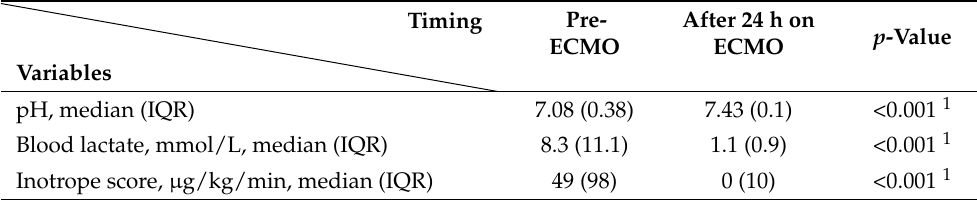
Table 2. pH, Blood lactate and inotrope score evolution before and 24 h after ECMO.